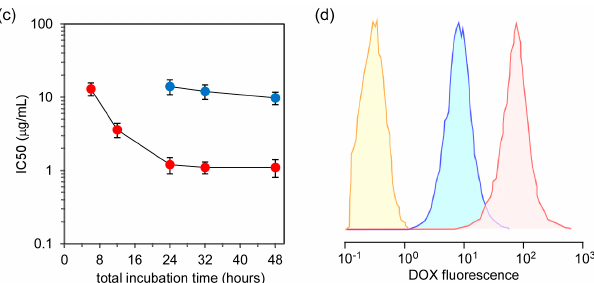
Figure 5. Anticancer effect of free DOX and DOX in SS-bonded nanocapsules to HeLa cells. The change in cell viabilities with different DOX concentrations and incubation periods for free DOX ( a ) and DOX in SS-bonded nanocapsules ( b ); Incubation time dependence of IC50 values for free DOX and DOX in SS-bonded nanocapsules ( c ); Fluorescence distribution of HeLa cells treated with free DOX and DOX in SS-bonded nanocapsules for 4 h ( d ). In ( a , b ), the plots for 6, 12, 24, 32, and 48 h total incubation are represented by closed circles, open circles, closed triangles, open triangles, and closed squares, respectively. The data are the average of three experiments ± SD. In ( c ), free DOX and DOX in SS-bonded nanocapsules are represented by red and blue plots, respectively. In ( d ), free DOX, DOX in SS-bonded nanocapsules and control (without treatment) are represented by red, blue, and yellow distributions.